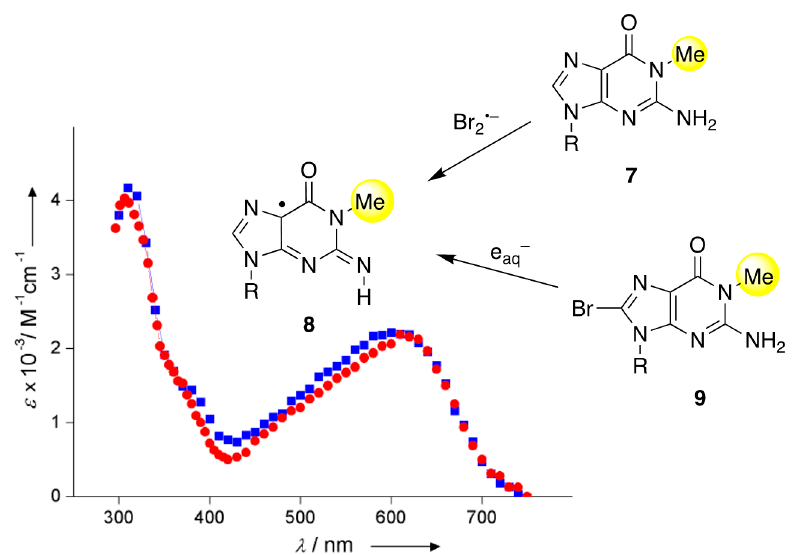
Figure 4. Absorption spectrum (red circles) refers to the oxidation of 7 by Br 2 •− and is assigned to the G(N2-H) • radical ( 8 ); for the ε values, G (Br 2 •− ) = 0.62 µ mol J − 1 was assumed (taken from [14]). The absorption spectrum (blue square) refers to the reduction of 9 by e aq − and is assigned to the same G(N2-H) • , having presumably the syn -conformation; for the ε values, G (e aq − ) = 0.27 μ mol J − 1 was assumed (taken from [28]). See Appendix A for radiation chemical yields.